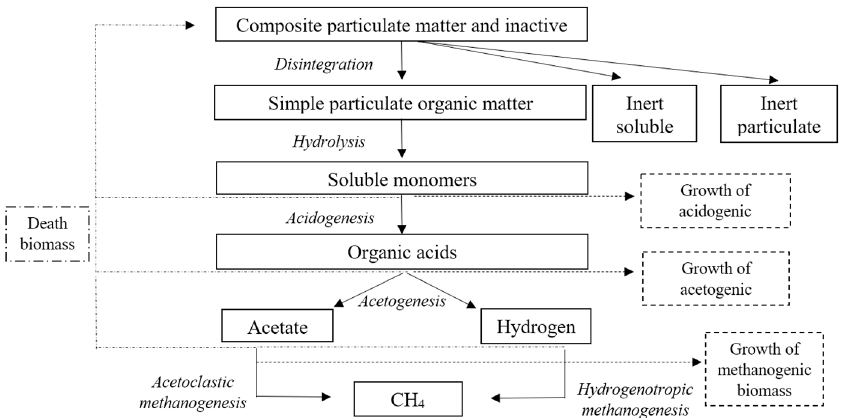
Figure 1. Steps of the AD process.